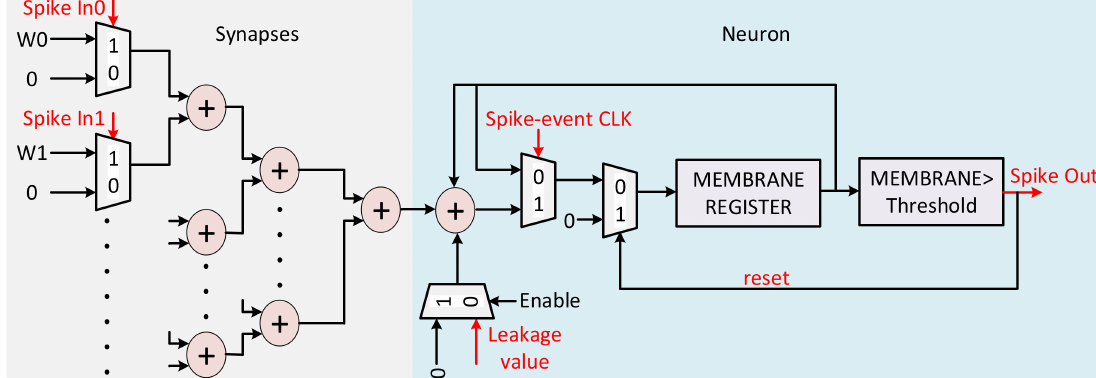
Figure 8. The block diagram of the full digital implementation for the output layer. A number of synapses accumulate in membrane register and the comparator fires the digital output spike pulses.